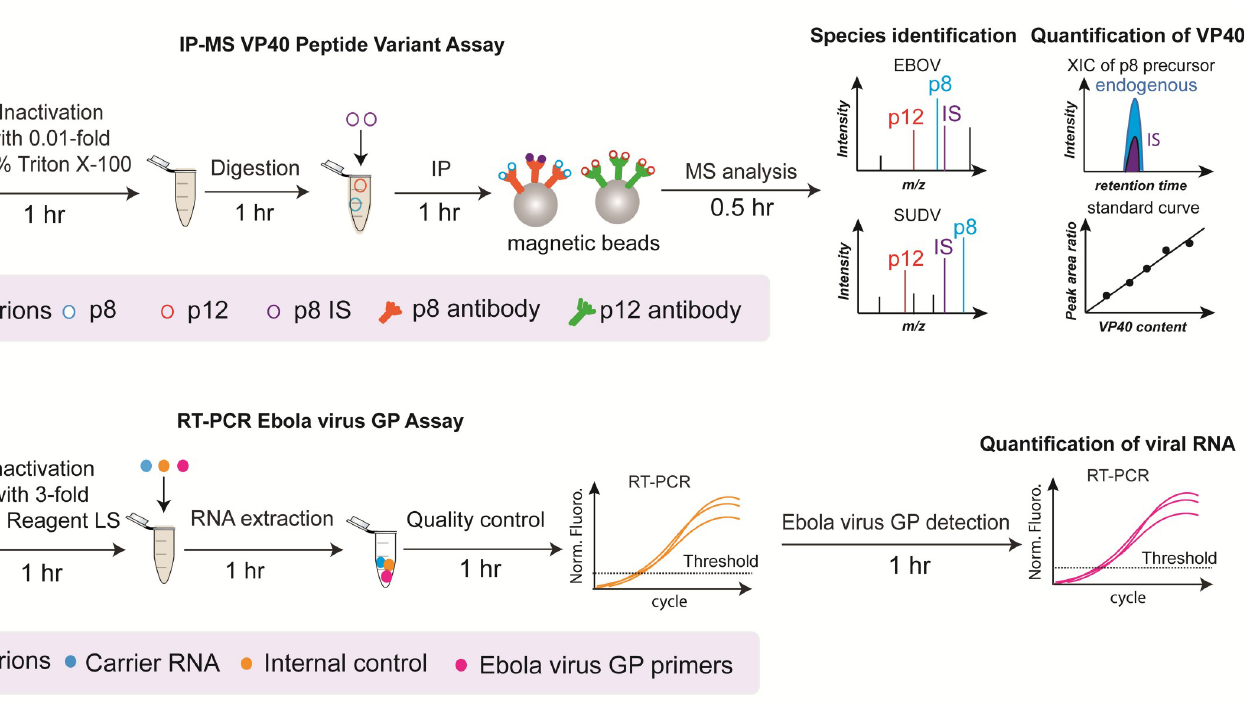
PLOS Pathogens| https://doi.org/10.1371/journal.ppat.1010039 November 8,